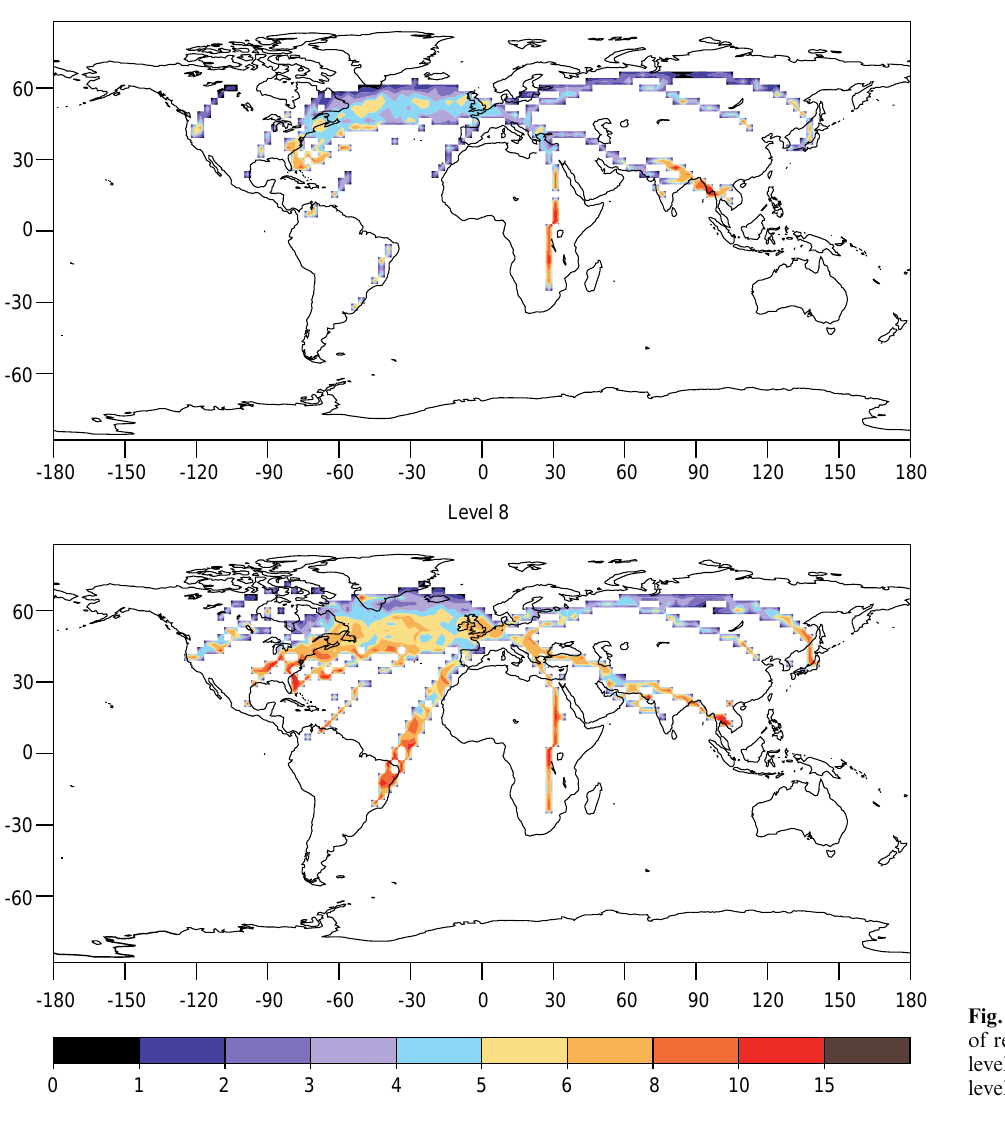
Fig. 3. Mean standard deviation of relative humidity in %. Mid- level pressures are 190 hPa for level 7 and 250 hPa for